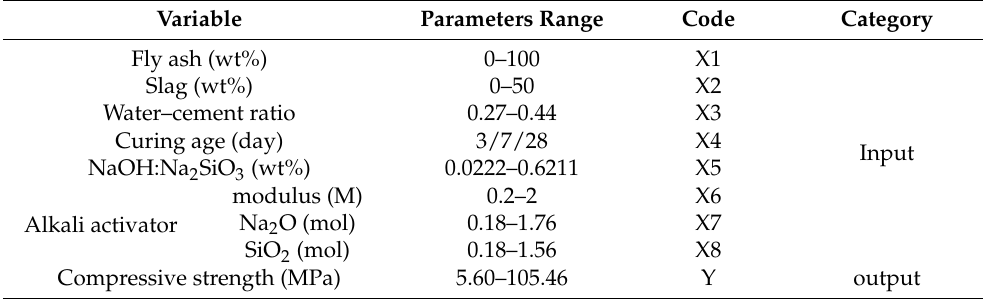
Table 4. The values of the neural network’s parameters. Variable Parameters Range Code